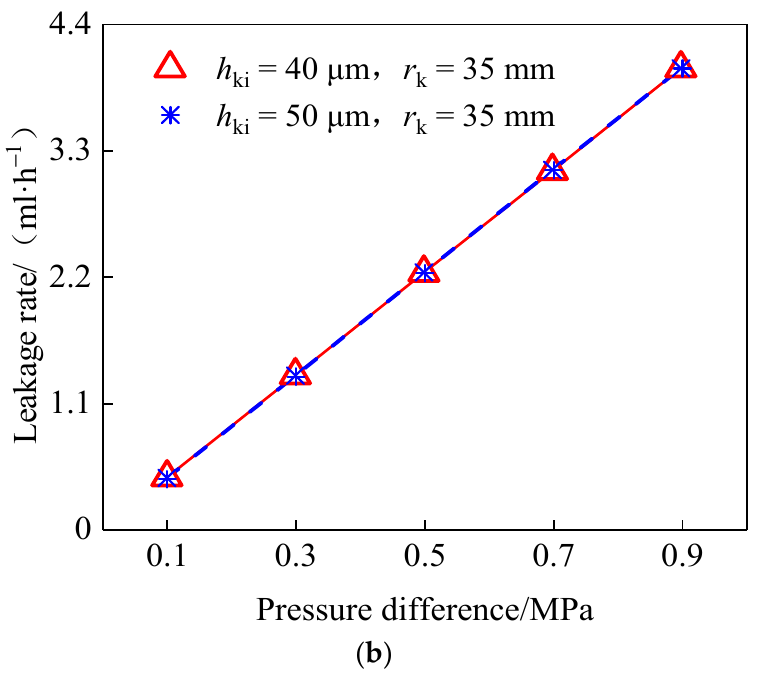
Figure 15. Influence of the sealing medium pressure difference on the sealing performance: ( a ) Influence on the opening force. ( b ) Influence on the leakage rate. ( h ki = h g = 50 μ m, r o = 30.6 mm, γ = 0.6, N g = 32, α = 34°, λ = 0.9, n = 6000 r·min − 1 ). Figure 16 illustrates the influence of rotating speed on the sealing performance. With the increase in rotating speed, the acceleration and pressurization of the spiral groove to the fluid intensify, resulting in further deceleration and diffusion when the fluid flows through the diffuser groove. Moreover, as the rotating speed increases, the fluid pressure peak increases, linearly increasing the opening force, as shown in Figure 16. Meanwhile, increasing the rotating speed also increases the spiral groove pumping capacity, which reduces the fluid pressure at the root of the spiral groove. This results in a decrease in the pressure difference on both sides of the sealing dam, reducing the leakage rate, as shown in Figure 16.